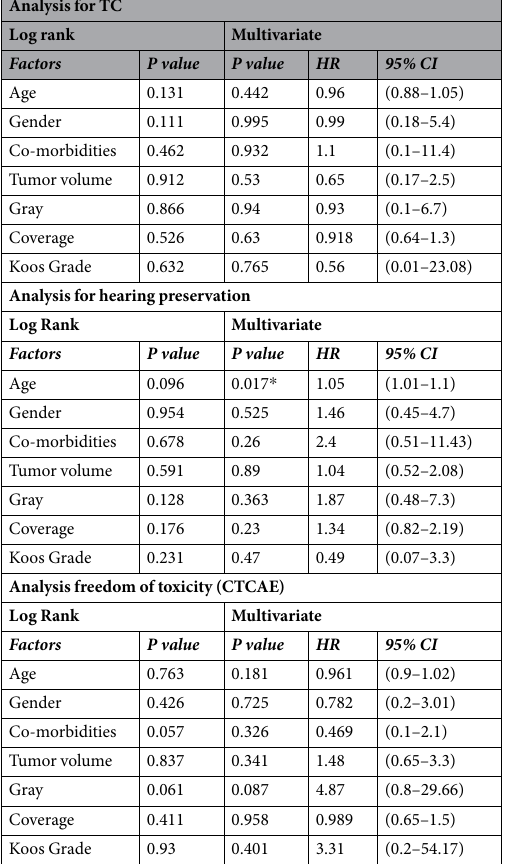
Table 2. Prognostic factors of VS treated with SRS. * P value < 0.05 is considered